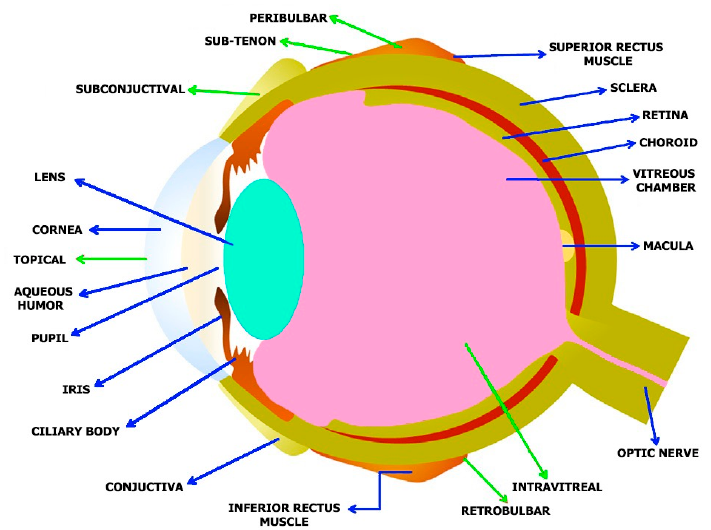
Figure 2. Anatomy of the human eye and administration routes for both nano based medicines and traditional drugs: Blue arrows indicates various eye structures and the green arrows indicate the various administration routes.